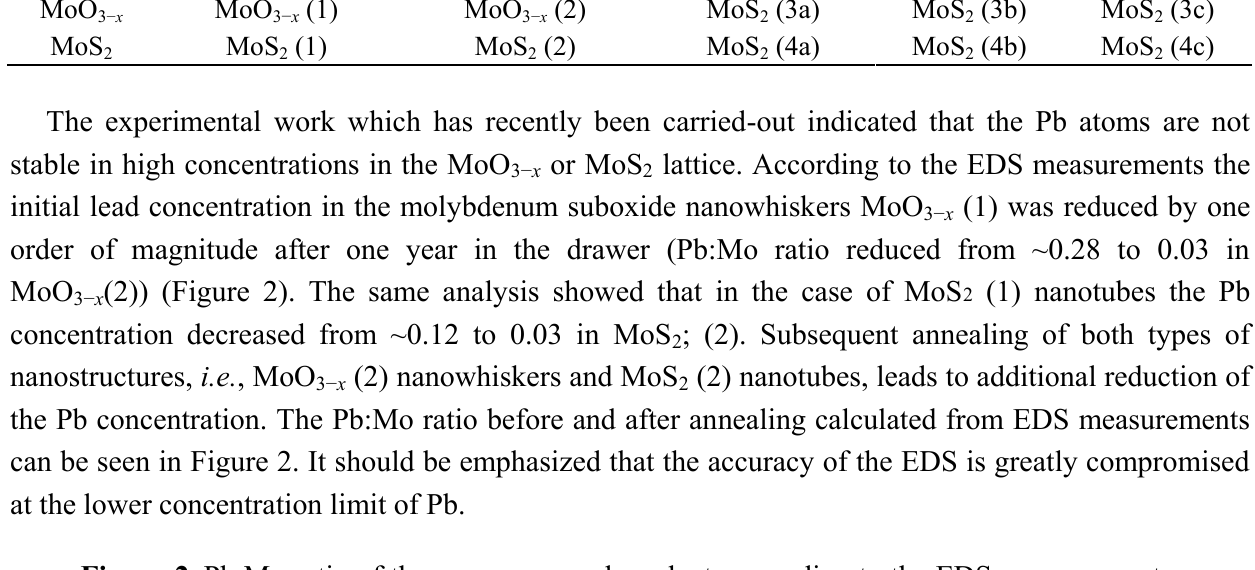
(2) nanotubes as a 2